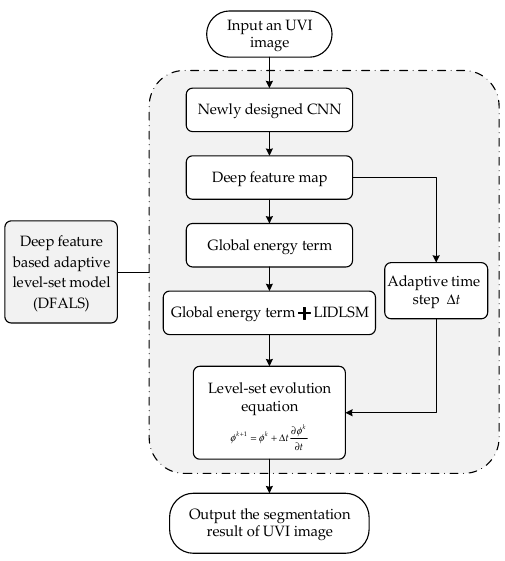
Figure 2. The flow diagram of the deep feature-based adaptive level set (DFALS)